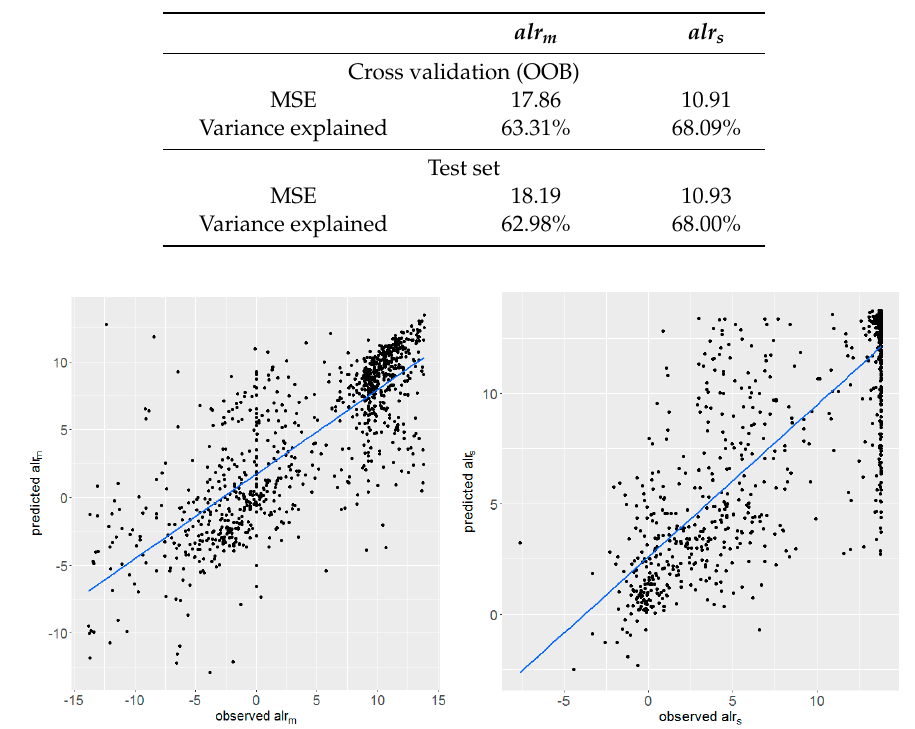
Figure 3. Observed versus predicted values for 1000 random test set observations.